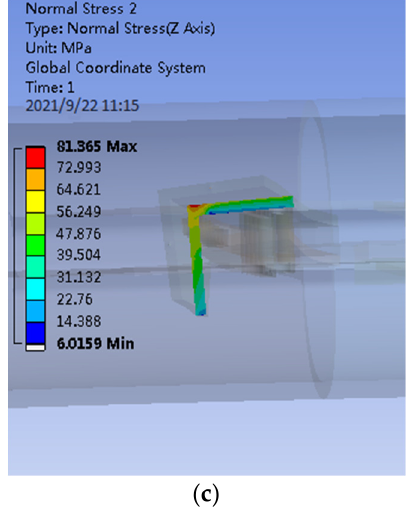
Figure 8. ( a ) Angle steel axle load diagram of PDLDPJ; ( b ) finite element results of short angle steel; ( c ) finite element results of long angle steel.